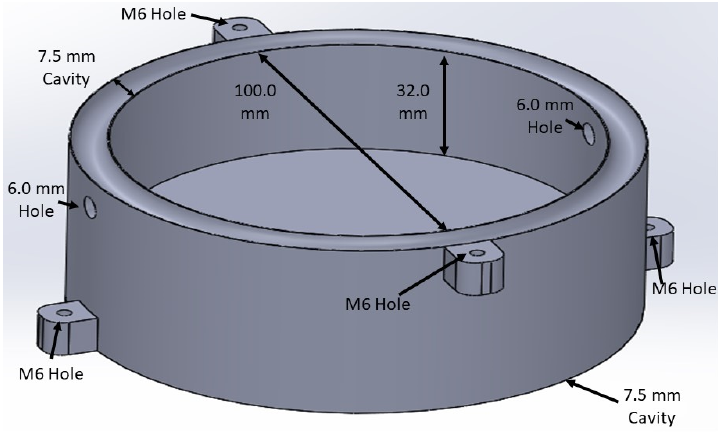
Figure 2. Illustration of Cell of the Cascade System for Biomineralization in Cement.